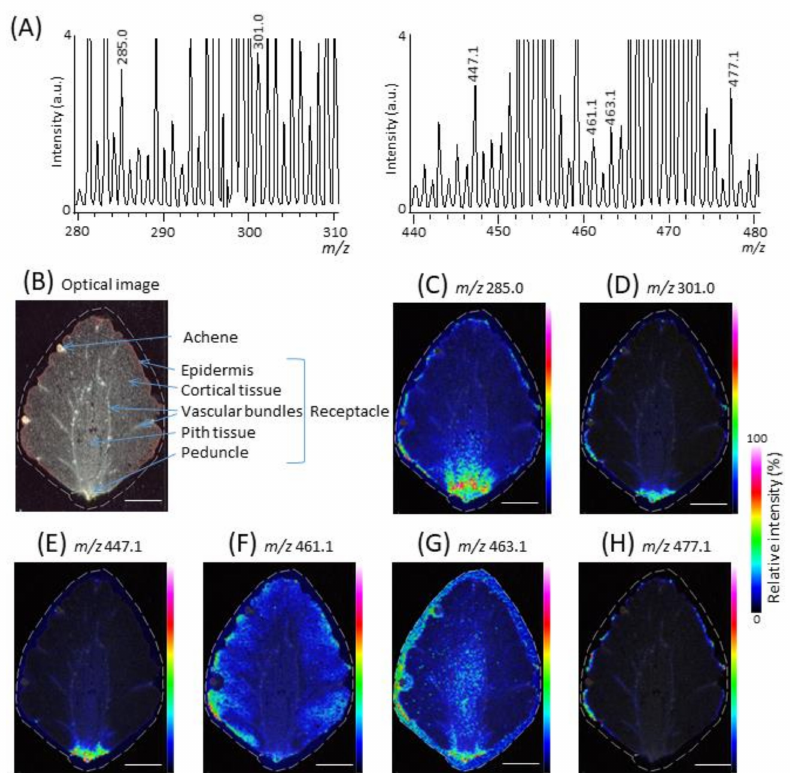
Figure 2. Matrix-assisted laser desorption / ionization-mass spectrometry imaging of the tentatively identified flavonols and ellagic acid glycosides in a ripe strawberry fruit section. ( A ) Mass spectra at m / z 280–310 and 440–480 of the section. Based on the m / z values, the peaks were tentatively identified as flavonols and / or ellagic acid glycosides. ( B ) Optical image of the section before measurement. Ion images at m / z ( C ) 285.0, ( D ) 301.0, ( E ) 447.1, ( F ) 461.1, ( G ) 463.1, and ( H ) 477.1. The dotted white line shows the analyzed region. Scale bar = 5